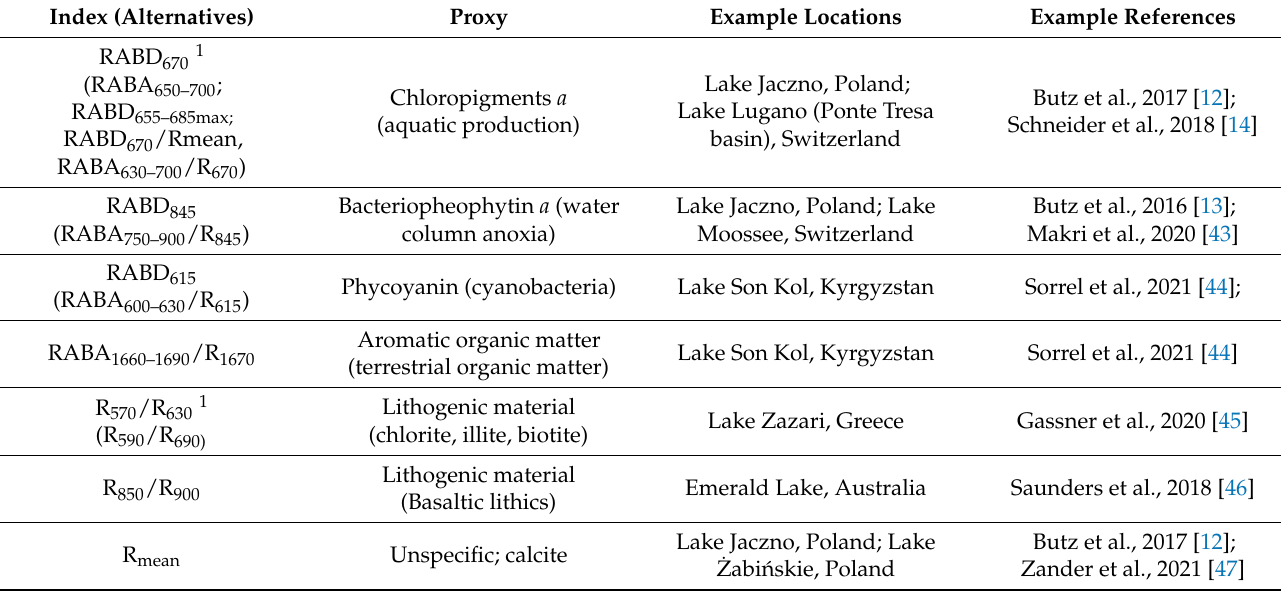
Table 2. List of spectral indices used in HSI studies of lake sediments.